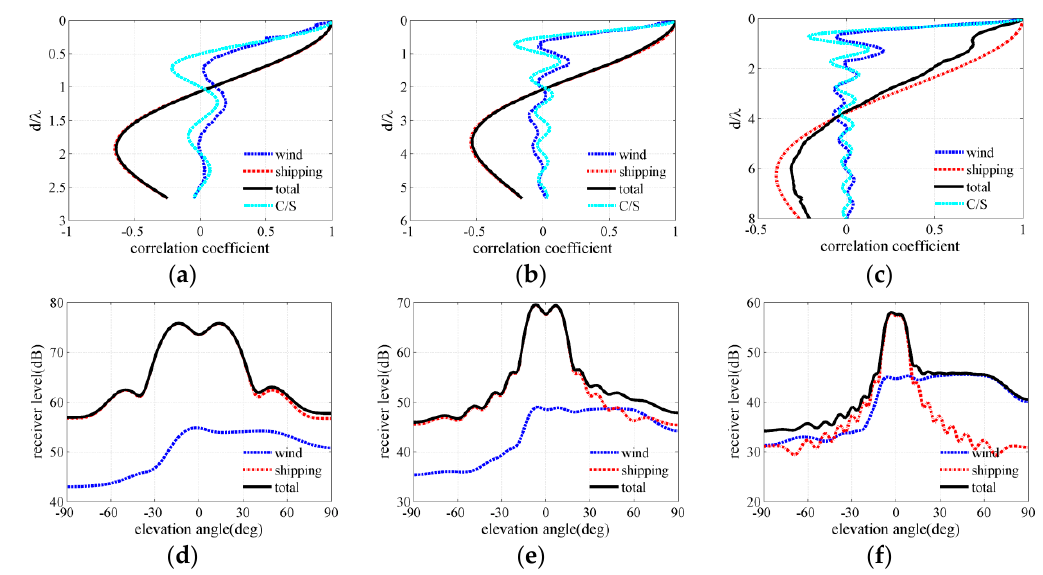
Figure 4. Vertical correlation and directionality at wind speed of 3 m/s for frequencies of ( a , d ) 50 Hz ( b , e ) 100 Hz and ( c , f ) 150 Hz.